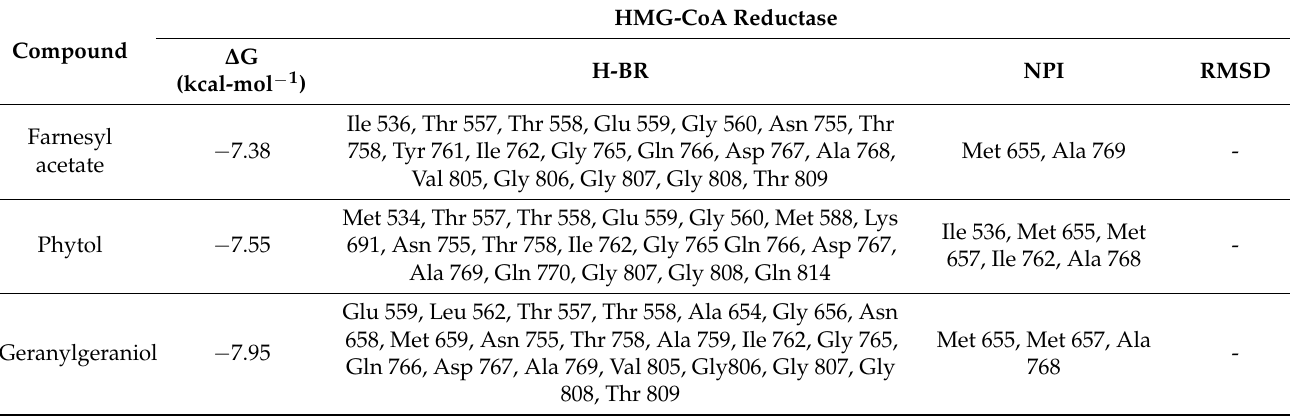
Table 7. Interactions of farnesyl acetate (FA), Phytol (PT), geranylgeraniol (Gg) and HMG CoA with residues on the binding sites of HMG-CoA